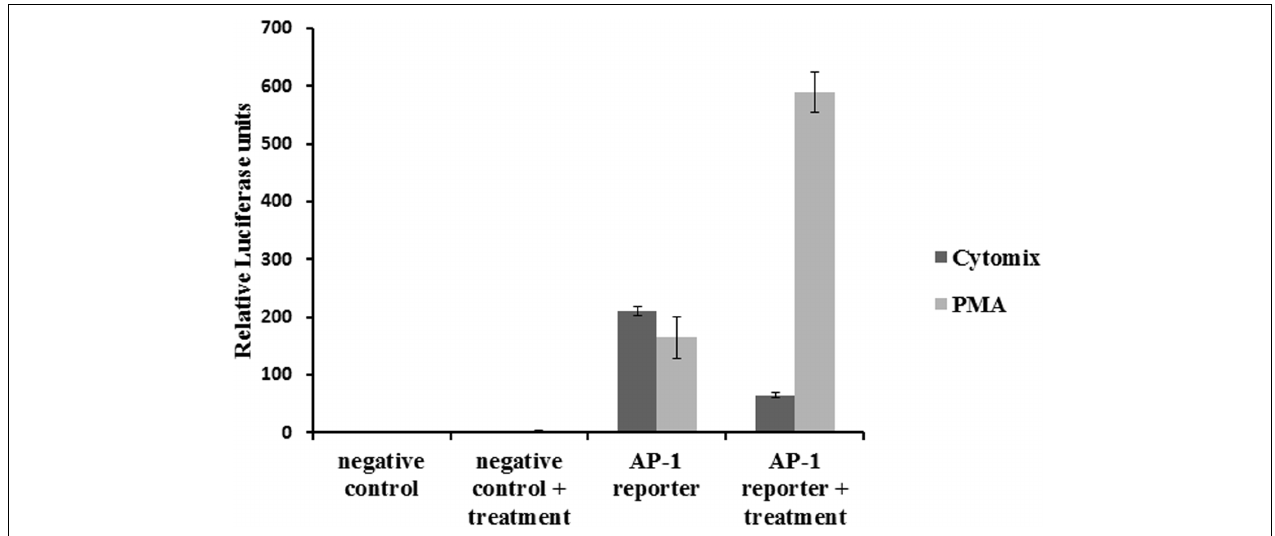
FIGURE 5 | Effect of the CM on AP-1 activity: NCM460 cells were transfected with luciferase plasmid under the control of AP-1. Cells were treated with PMA (10 ng/ml) or the CM (10 ng/ml TNF- α , 5 ng/ml IL-1 β , and 10 ng/ml IFN- γ ) for 24 h. Cell lysates were analyzed for luciferase activity.